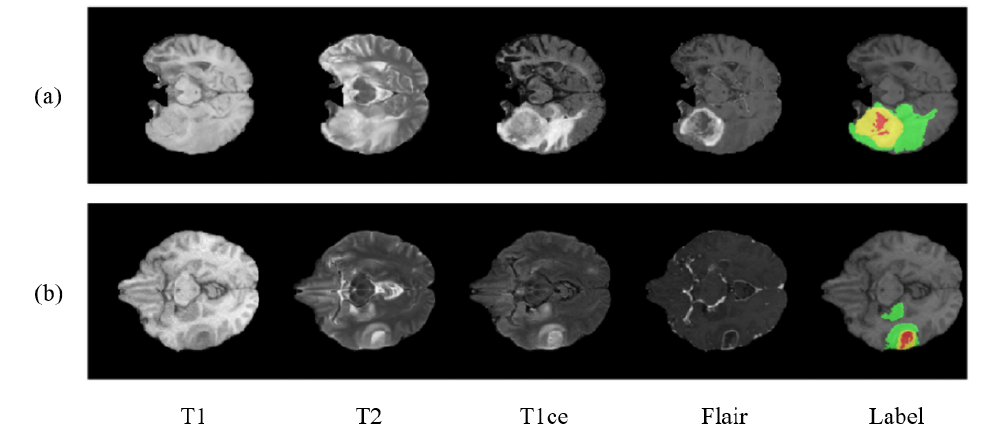
Figure 1. Showing two cases ( a , b ) of a brain tumor with multimodal and labeled plots. From left to right are T1, T2, T1ce (T1c), flair, and the ground truth (labels). In ground truth images there are 3 colors used to represent three different tumor classes. Red represents necrosis and non-enhancing; green represents edema; and yellow represents an enhancing